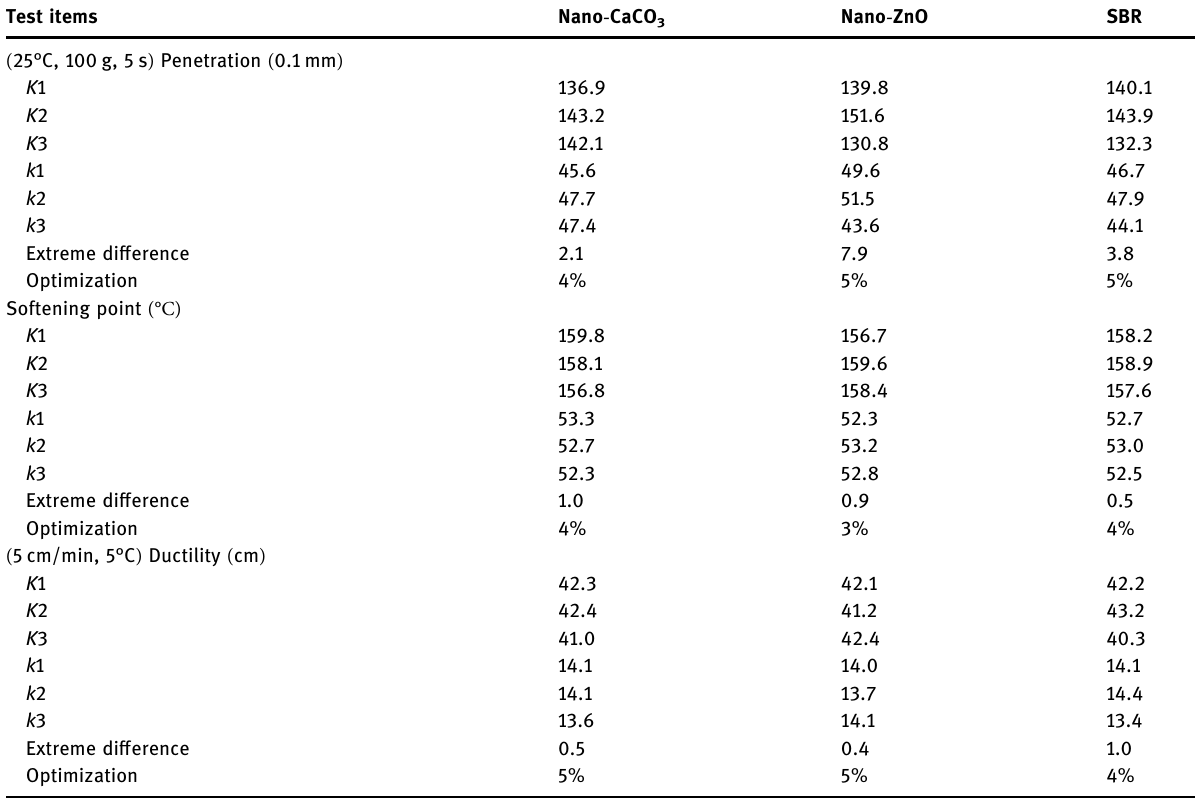
Table 6: Range calculation results of orthogonal experiment Test items Nano - CaCO 3 Nano - ZnO